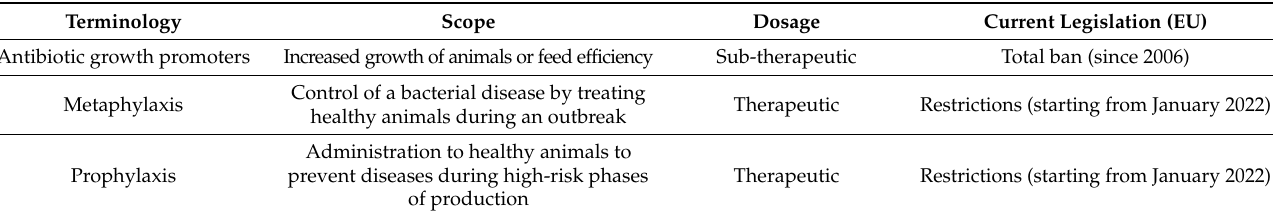
Table 1. Non-therapeutic use of antimicrobials in food-producing